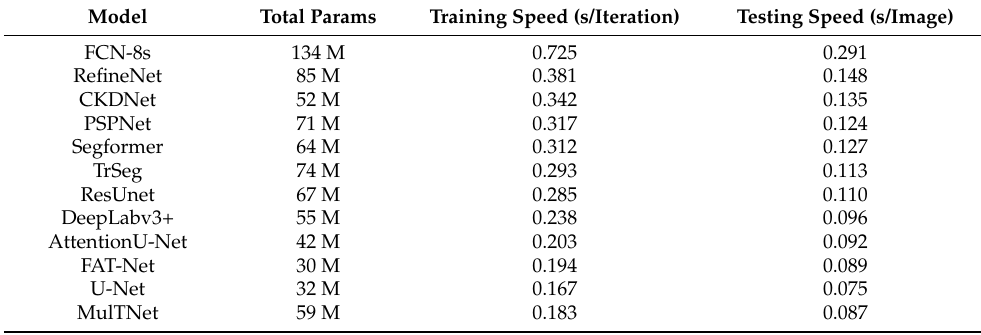
Table 5. Comparison of computational costs.